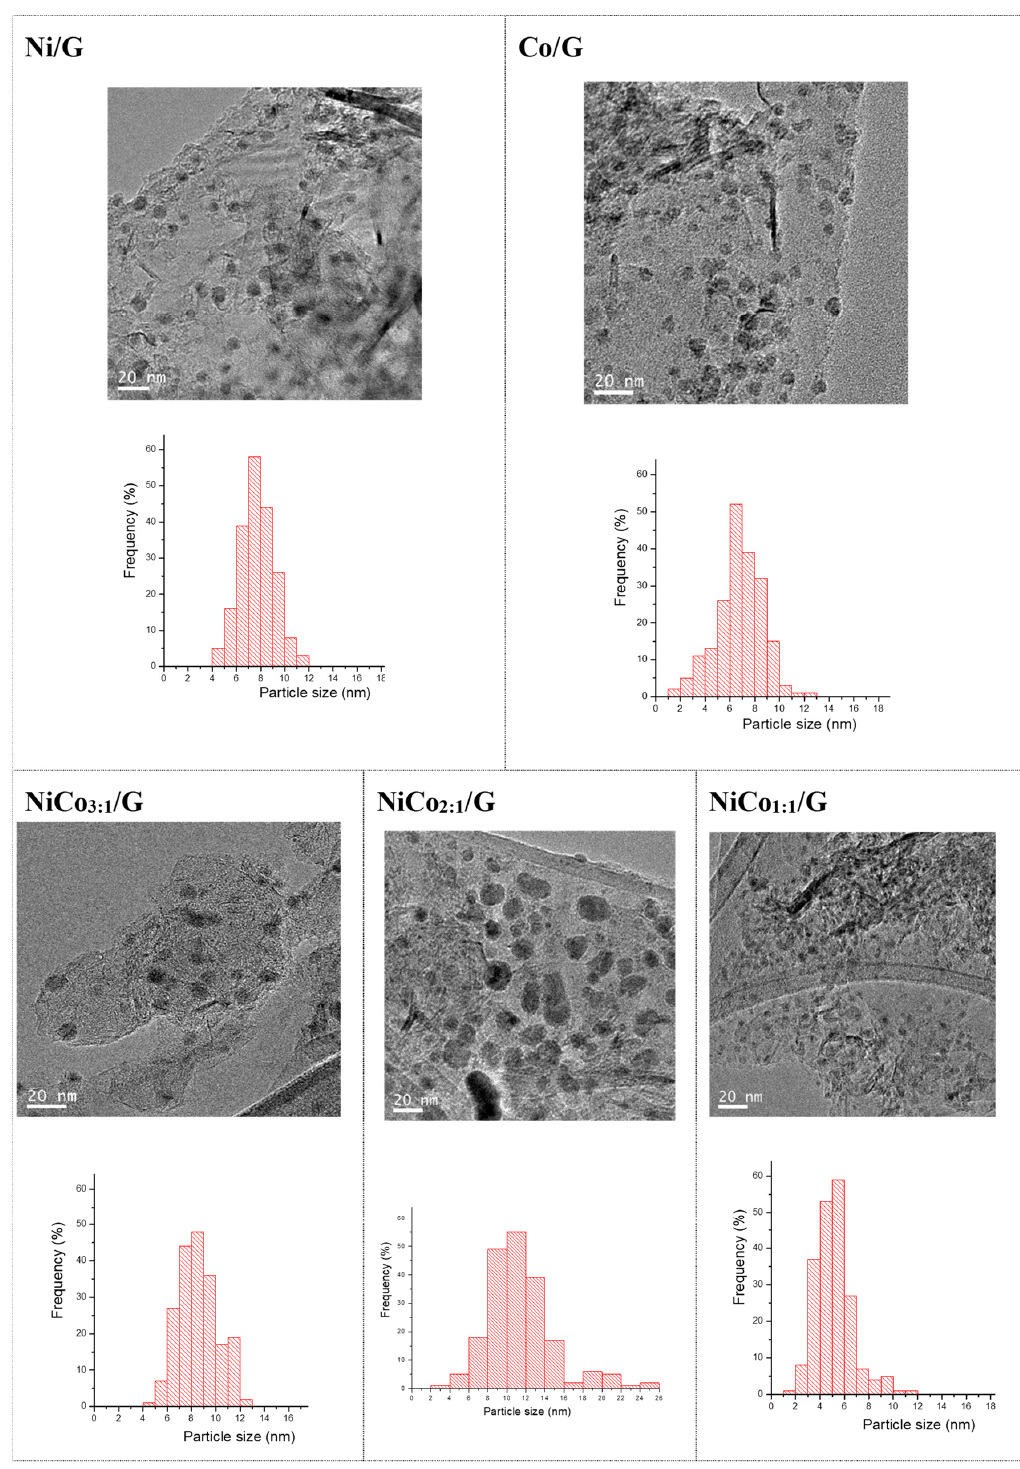
Figure 3. TEM images and histograms of the catalysts.